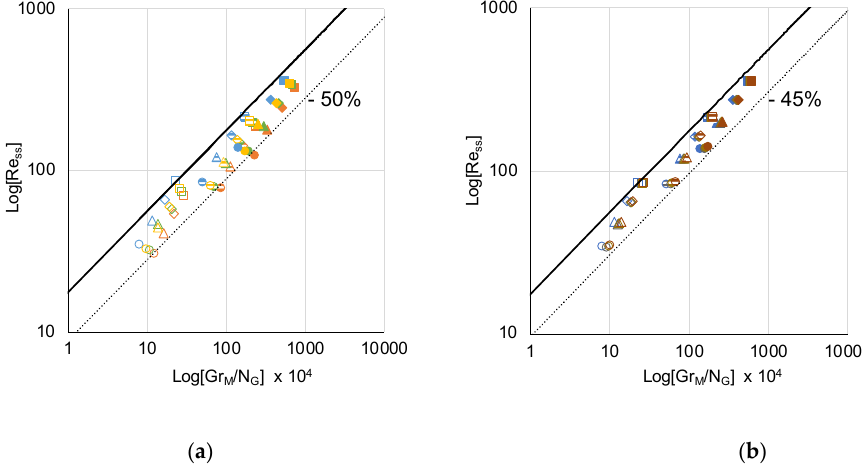
Figure 7. Comparison of the results with the Vijayan’s correlation (Equation (15)) for ( a ) MTP and ( b ) PTP cases.